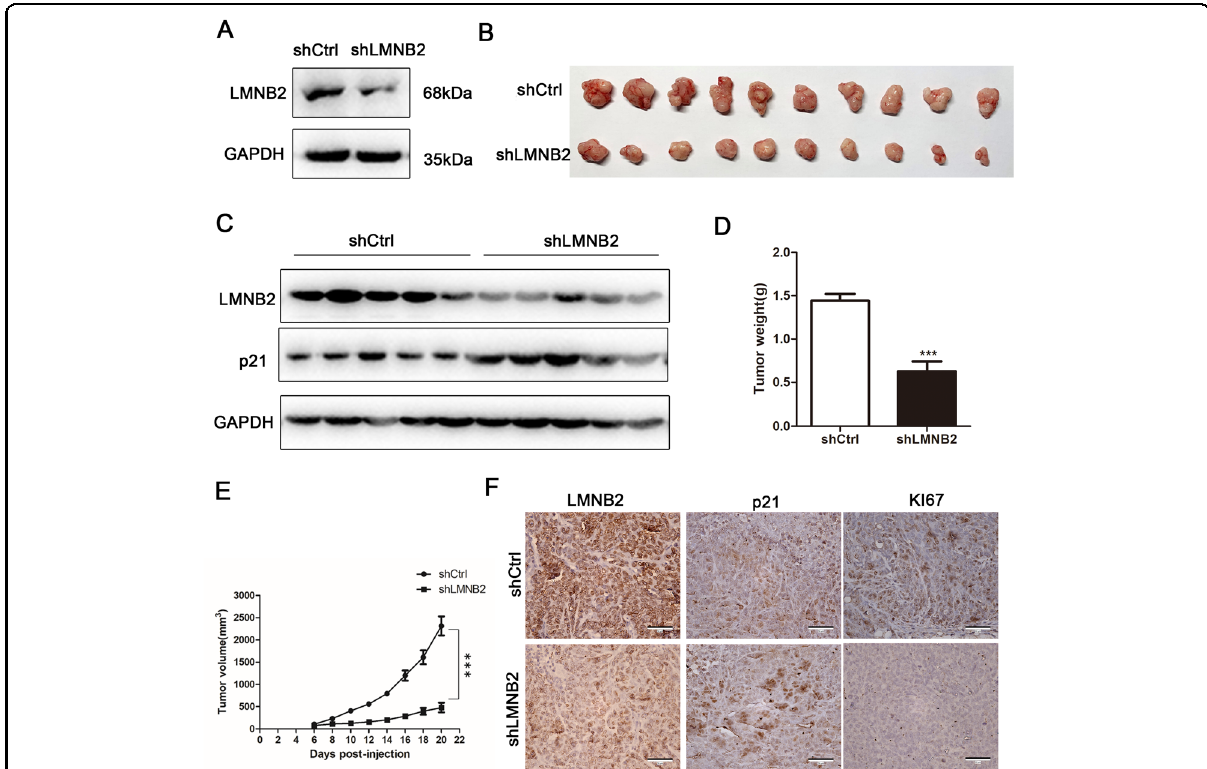
Fig. 5 Knockout of the LMNB2 gene can inhibit tumor formation in colorectal cancer cells. A Western blotting con fi rmed that the LMNB2 gene was knocked out in the HCT116 stable cell line at the protein level. B Gross observation of subcutaneous tumors of nude mice on HCT116 cells transfected with shLMNB2 and shCtrl lentivirus (10 mice per group). The mice were killed 20 days after injection and the transplanted tumors were collected. C Detection of LMNB2 protein levels in fi ve cancer tissues and paired normal colon tissues by western blotting. D Analyze the weight of the transplanted tumor. E The volume of transplanted tumor in nude mice. The calculation formula of transplanted tumor volume is: V = ( L × W 2)/2. F Tumor sections were immunohistochemically stained with antibodies against LMNB2, p21, and Ki67, and a representative image was displayed (magni fi cation: ×400). * P < 0.05. L represents the long axis, W represents the short